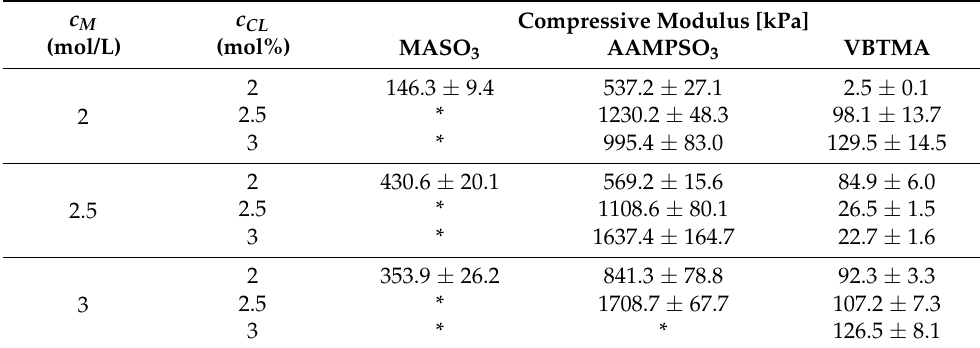
Figure 3. Mechanical characterization of MASO 3 (2 mol/L) with BAP (2 mol%) as a crosslinker: ( a ) technical stress-strain curves of three single measurements with the swollen hydrogel until break- age and ( b ) linear interpolation of the data from ɛ = 2 − 7% to determine the compressive modulus. Table 3. Comparison of the compressive moduli of the investigated swollen hydrogels in PBS with different monomers and BAP as a